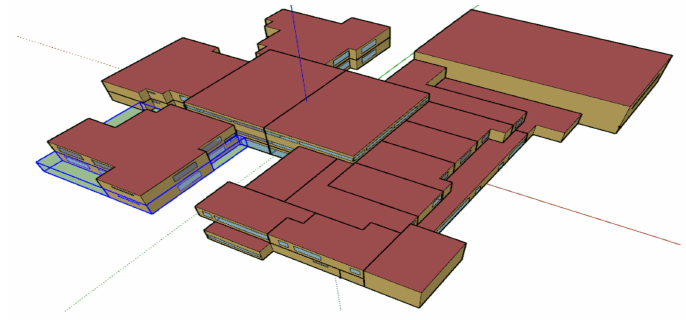
Figure A1. School 3D model.